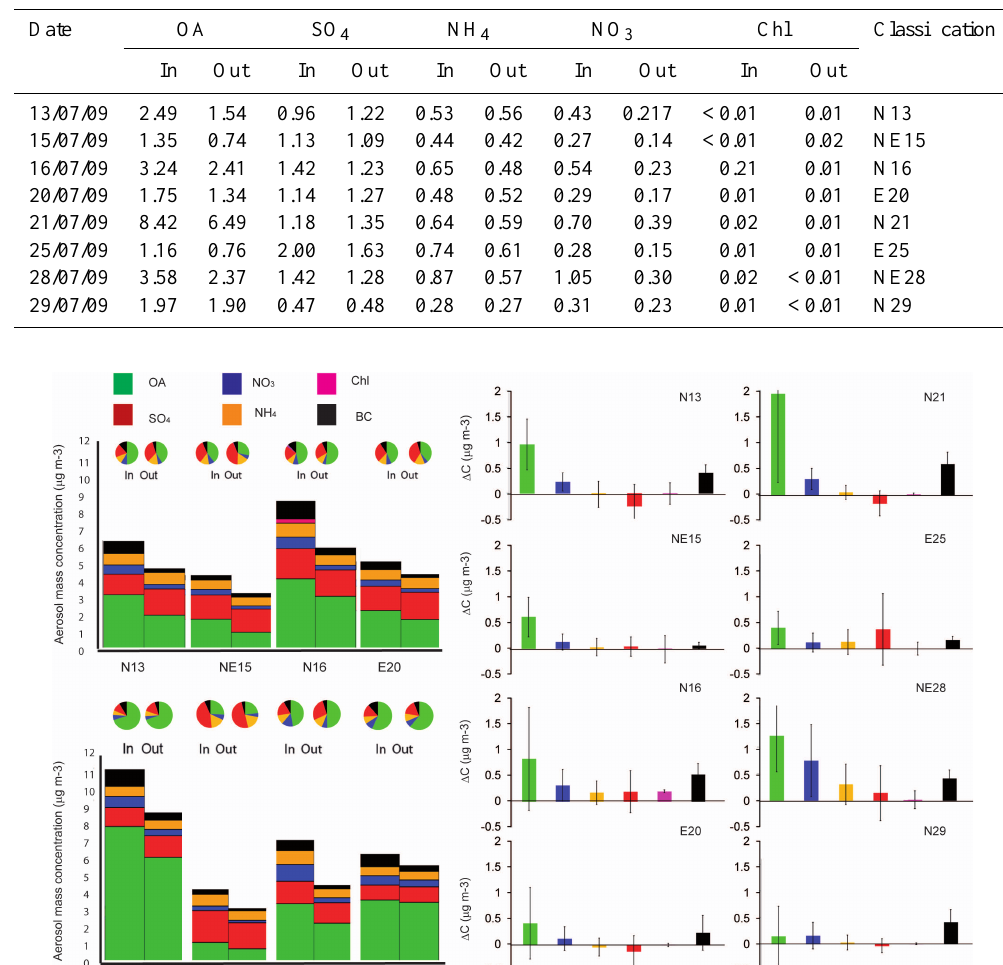
Table 2. Particle compositions inside and outside of the plume. All concentrations are in µgm − 3 . Date OA SO 4